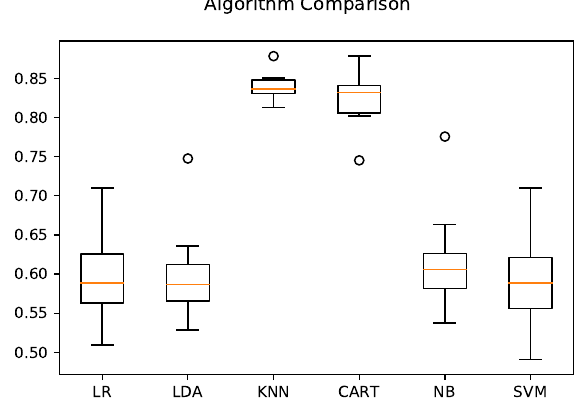
Figure 7. Boxplot of comparison of the ML algorithms on the harvest data. The KNN and CART algorithms stand out clearly from the rest.